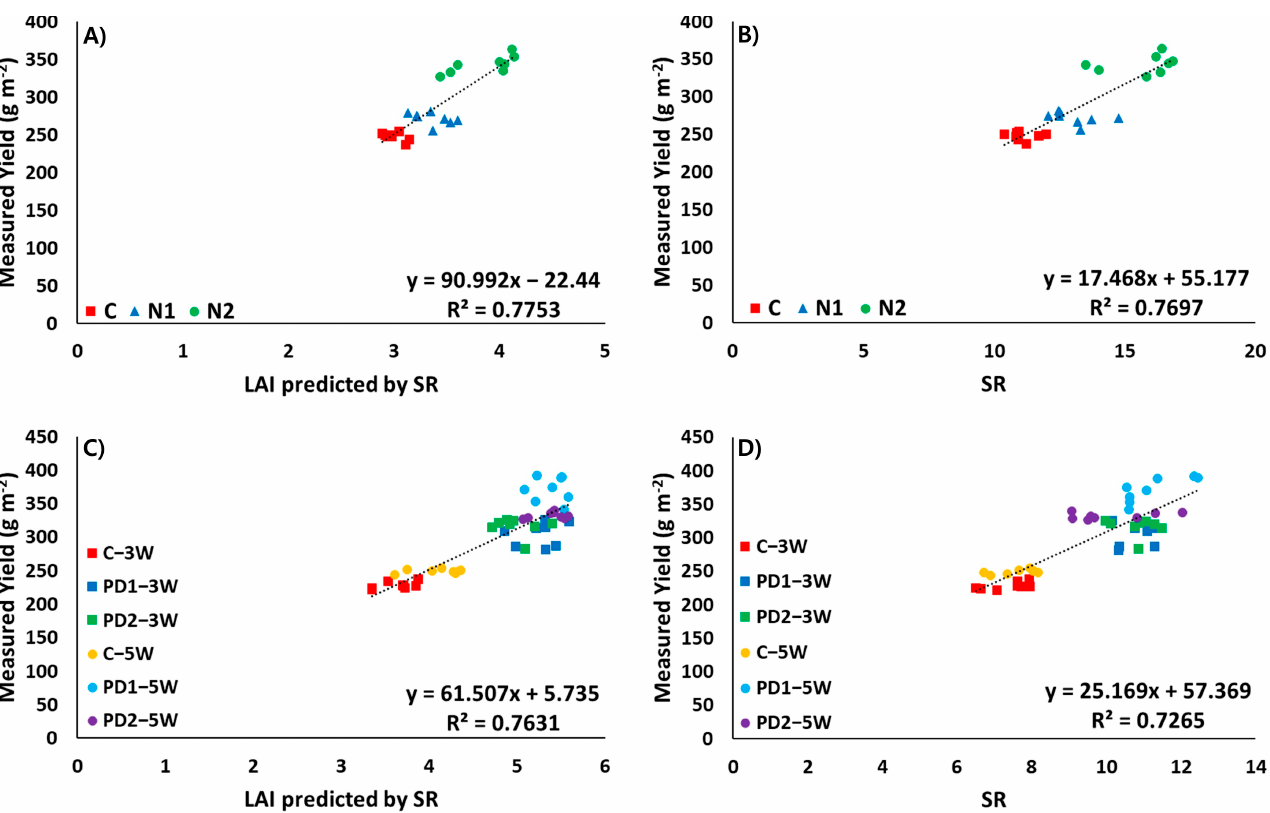
Figure 7. Regression analysis between the measured yield and ( A ) LAI predicted by the SR in 2018;